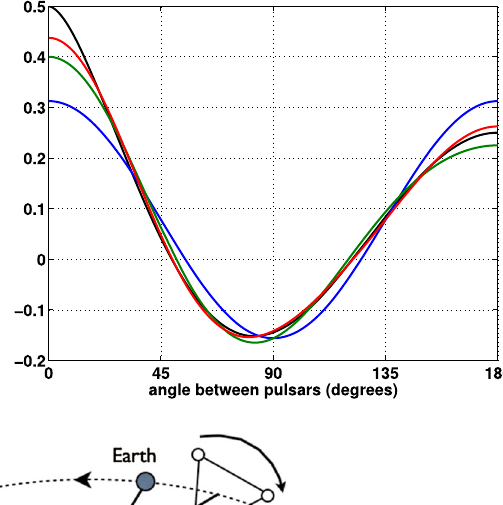
Fig. 38 Comparison of the exact expression of the Hellings and Downs curve ( black ) with Legendre series approximations for different values of l max . The blue , green , and red curves correspond to l max = 2, 3, and 4, respectively